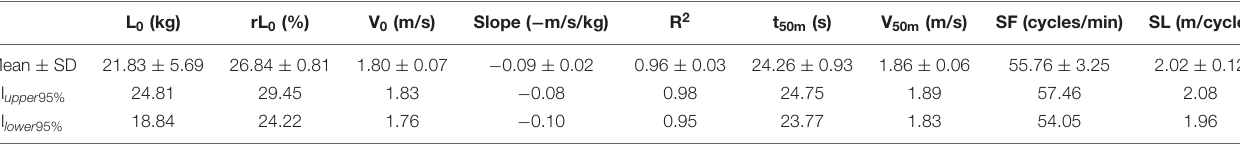
SD = standard deviation; CI upper95% = upper bound of 95% confidential interval of Mean; CI lower95% = lower bound of 95% confidential interval of Mean; L 0 = estimated maximum load from the load-velocity slope; rL 0 = estimated maximum load as a percentage of body mass; V 0 = estimated maximum velocity from the load-velocity slope; Slope = steepness of load-velocity regression; R 2 = coefficient of determination of the load-velocity regression line; t 50m = time for the 50 m front crawl; V 50m = mean free-swimming velocity during 50 m front crawl; SF = stroke frequency for the 50 m front crawl; SL = stroke length for the 50 m front crawl.